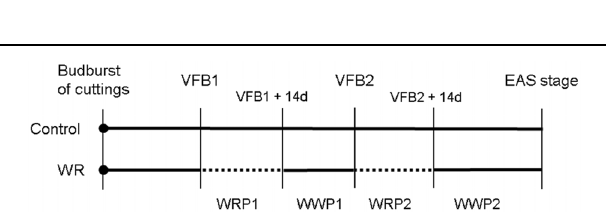
FIGURE 2 | Application of the water restriction (WR) treatment based on developmental stage of the primary axis [bud burst of the rooted cutting, visible flower bud of the order 1 axis (VFB1), visible flower bud of the order 2 axes (VFB2) and elementary architectural structure (EAS) stage]. 14-days (14d) periods of water restriction (WRP1 and WRP2) are indicated by dotted lines and periods of re-watering (WWP1 and WWP2) by continuous